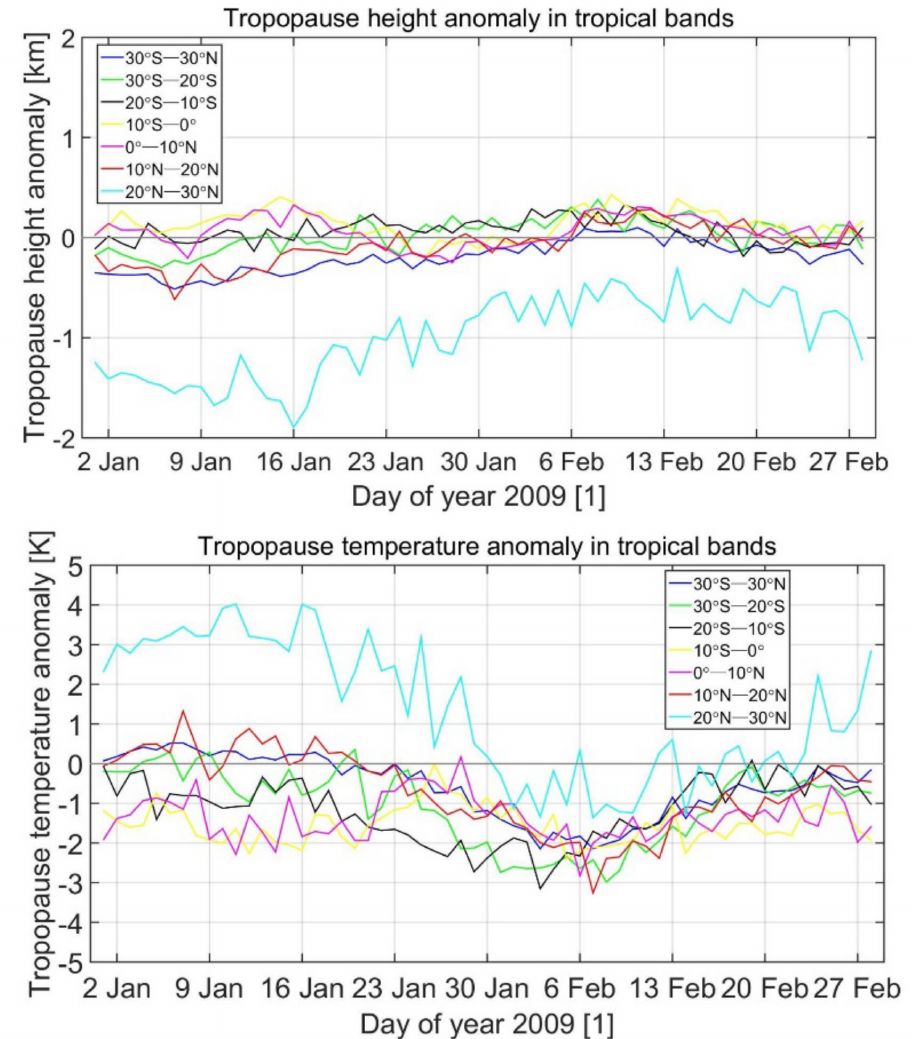
Figure 10. Daily timeseries of latitudinal mean tropopause height and temperature anomalies in trop- ical bands of 30 ◦ S − 30 ◦ N, 30 ◦ S − 20 ◦ S, 20 ◦ S − 10 ◦ S, 10 ◦ S − 0, 0 − 10 ◦ N, 10 ◦ N − 20 ◦ N, and 20 ◦ N − 30 ◦ N during January and February